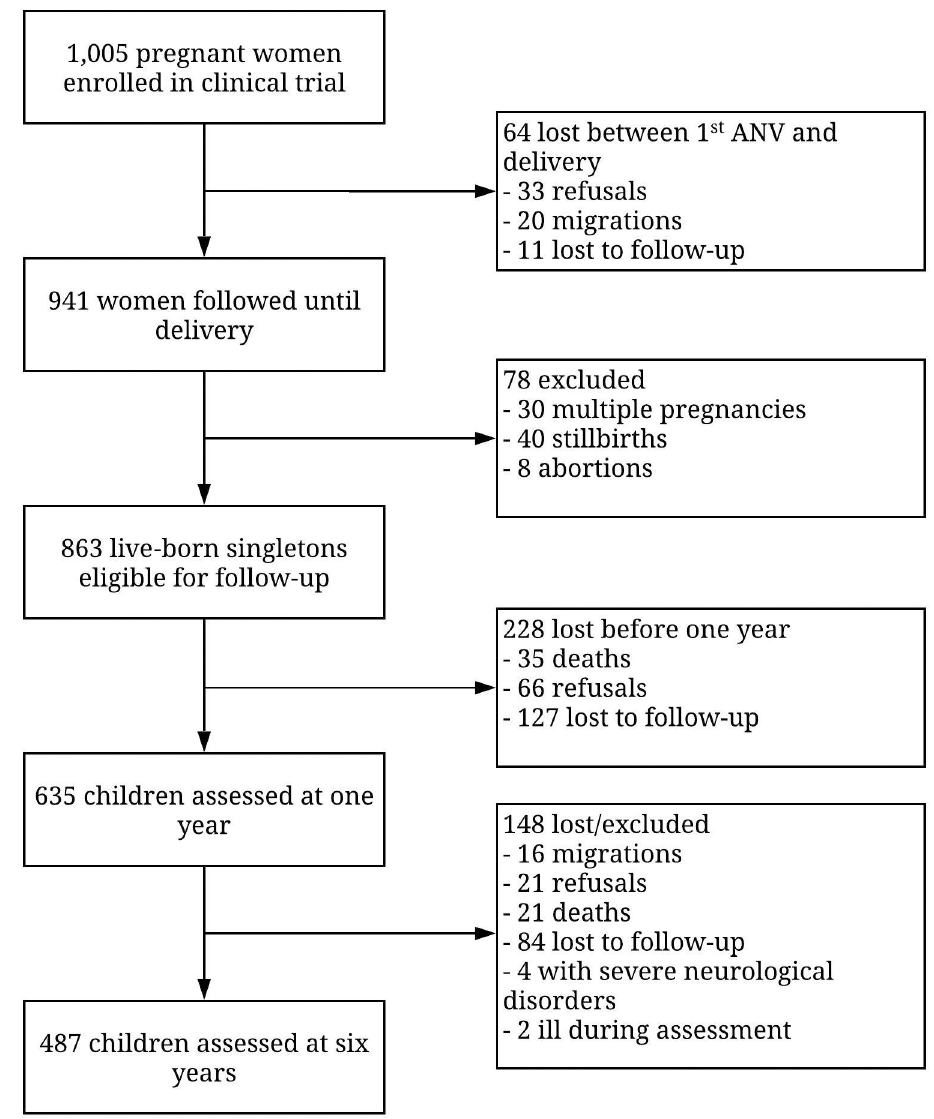
Fig 1. Population flowchart from second trimester of pregnancy until child follow-up at six years of